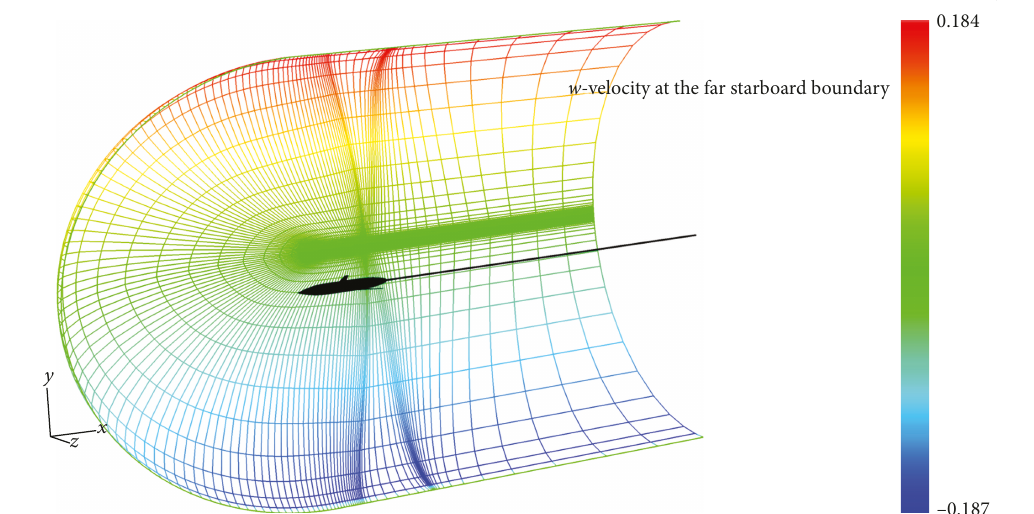
Figure 26: Side wind shear showing w -velocity components at the far starboard